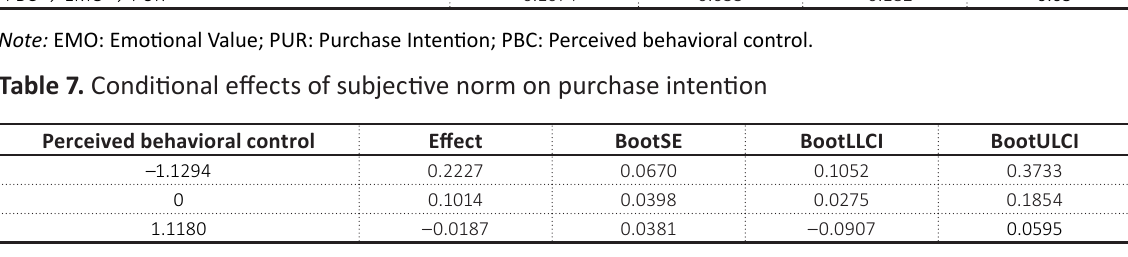
44.8045.0045.2045.405.60